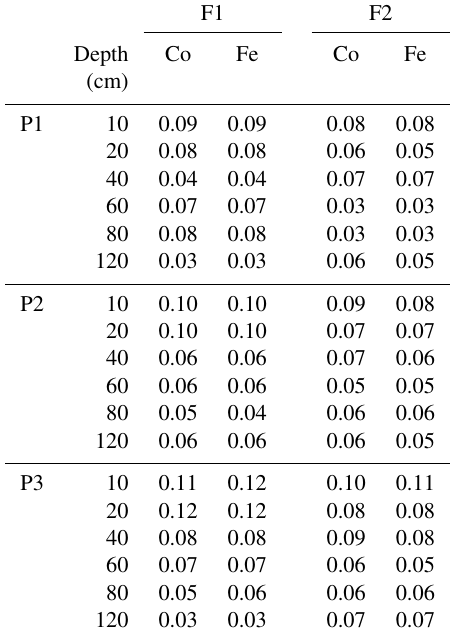
Table G1. Statistic RMSEs of soil water content simulated by the Couvreur (Co) and Feddes (Fe) models in the sheltered (P1), rain- fed (P2), and irrigated (P3) plots of the stony soil (F1) and the silty soil (F2). RMSE is given in cm 3 cm − 3